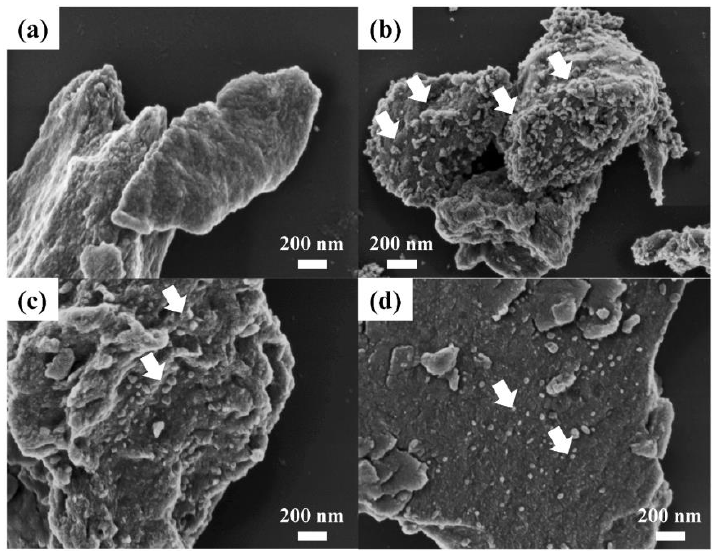
Figure 2. Field emission-scanning electron micrographs of ( a ) pristine MgAl–citrate LDH, ( b ) SONP@LDH-1, ( c ) SONP@LDH-1/3 and ( d ) SONP@LDH-1/10.